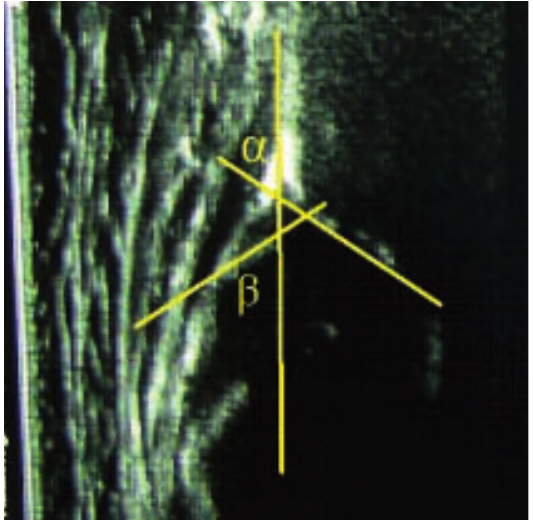
Example of assess- ment with alpha and beta angles marked on a